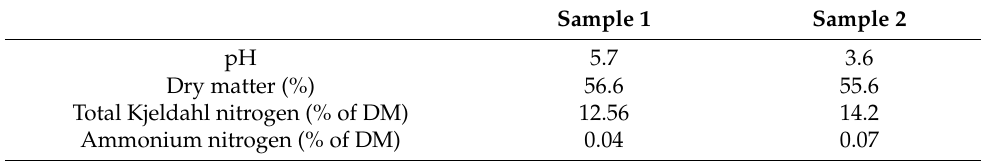
Table 2. Research results on mizdra biogas yield.